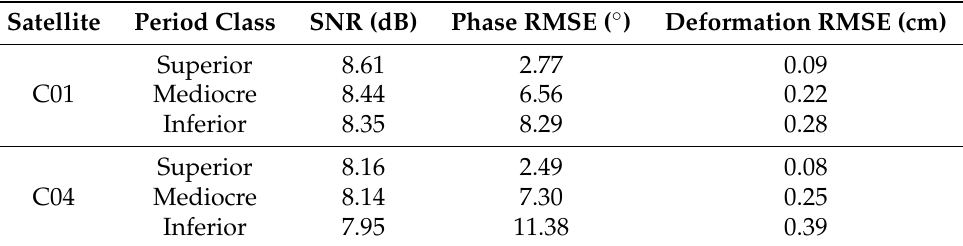
Table 5. Analysis of SNR on phase stability and deformation estimation